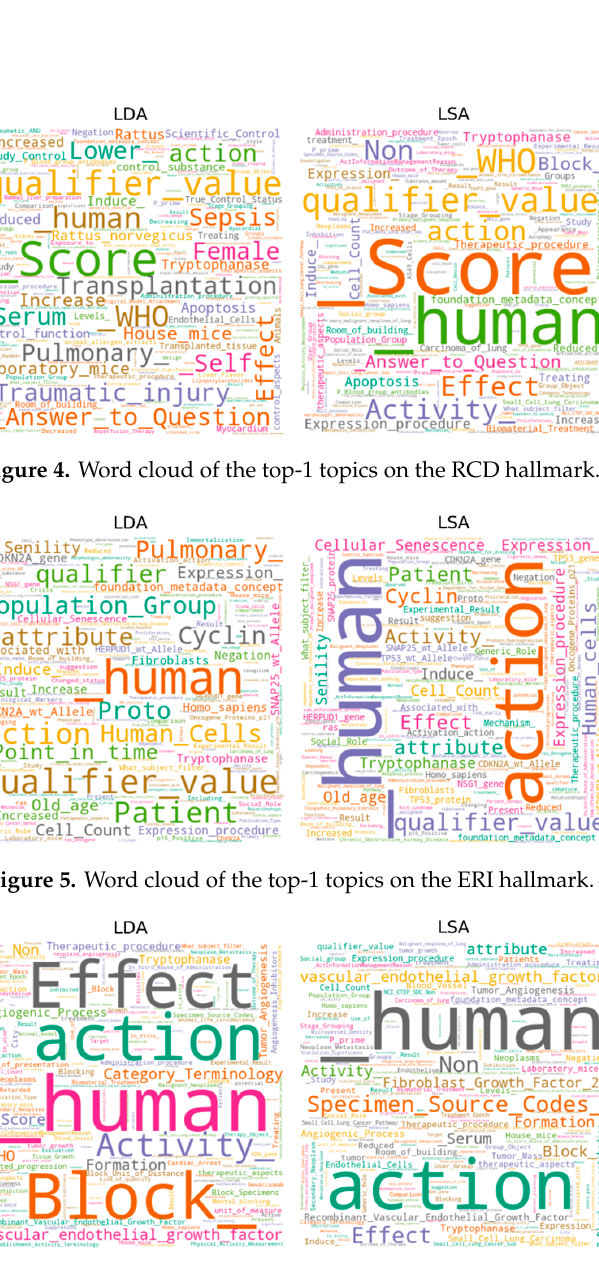
Figure 6. Word cloud of the top-1 topics on the IA hallmark.